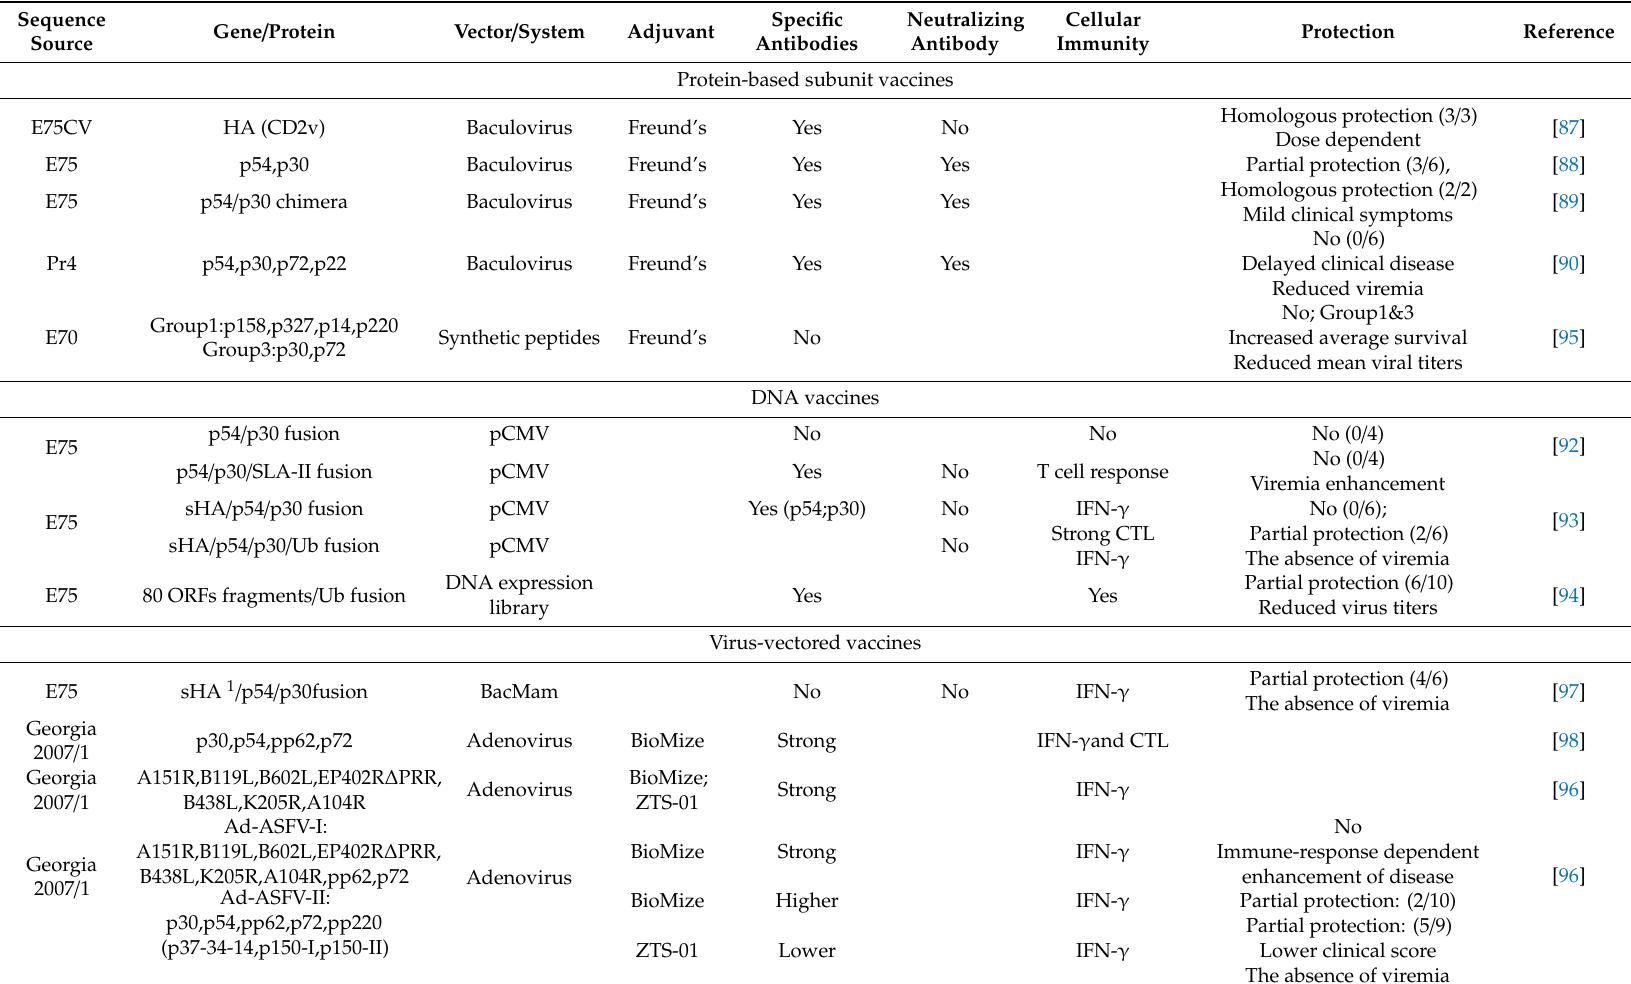
Table 4. Evolving strategies for ASFV genetically engineered